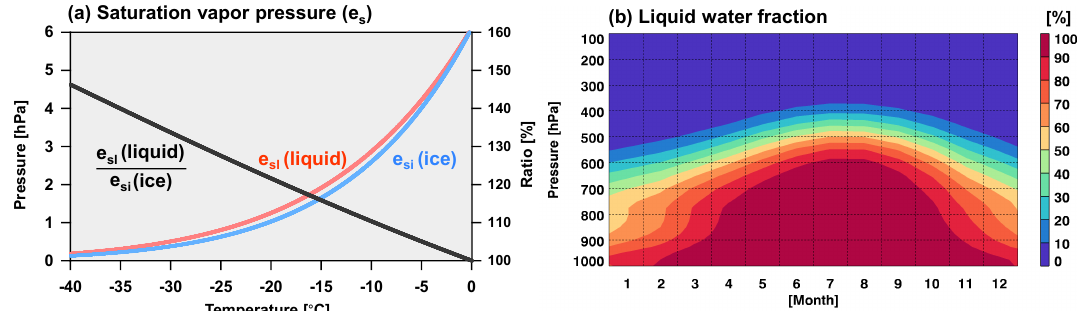
Figure 2. ( a ) Saturation vapor pressures over liquid and ice (e sl and e si ). ( b ) Monthly climatology for Table 1. RHL was applied for temperatures ≥ 0 ◦ C (Equation (2)), whereas RHI was used for temperatures < − 23 ◦ C (Equation (3)). For temperatures between − 23 ◦ C and 0 ◦ C, Equation (4) was used to estimate relative humidity.